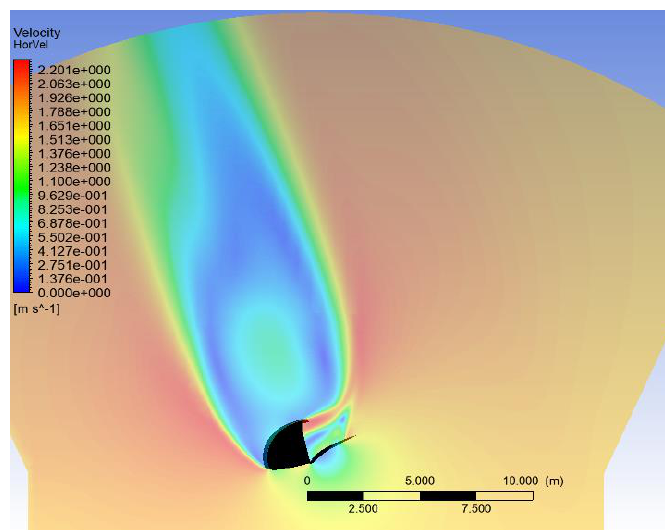
Figure 8. Velocity contour plots at the mid-height section for AWA = 115°.